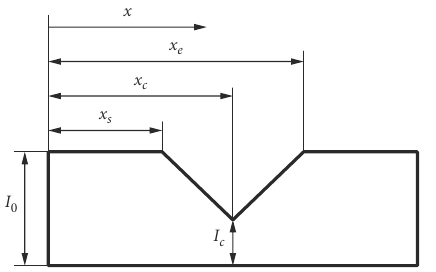
Figure 14. Crack region modelling using a triangular section